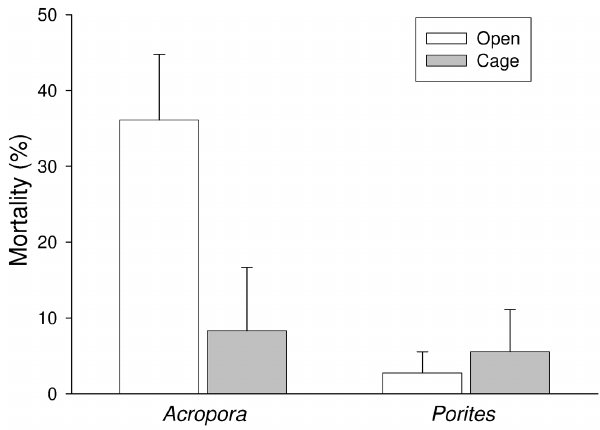
Figure 2. Percentage mortality (mean + 1SE) of Acroporapulchra and Poritesrus in open and caged slabs. Data are pooled across